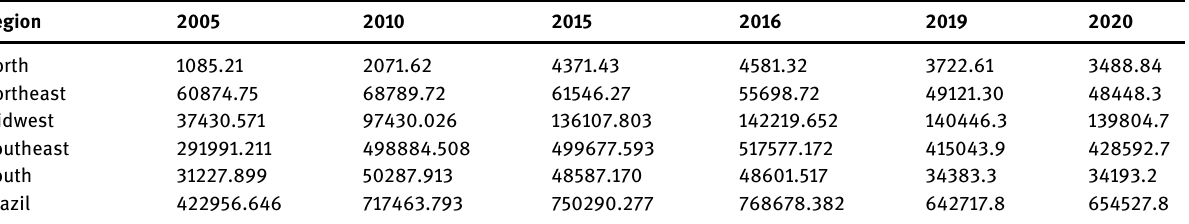
Table 1: Production ( in thousand t ) of sugarcane in Brazil and regions ( 2005 – 2020 )